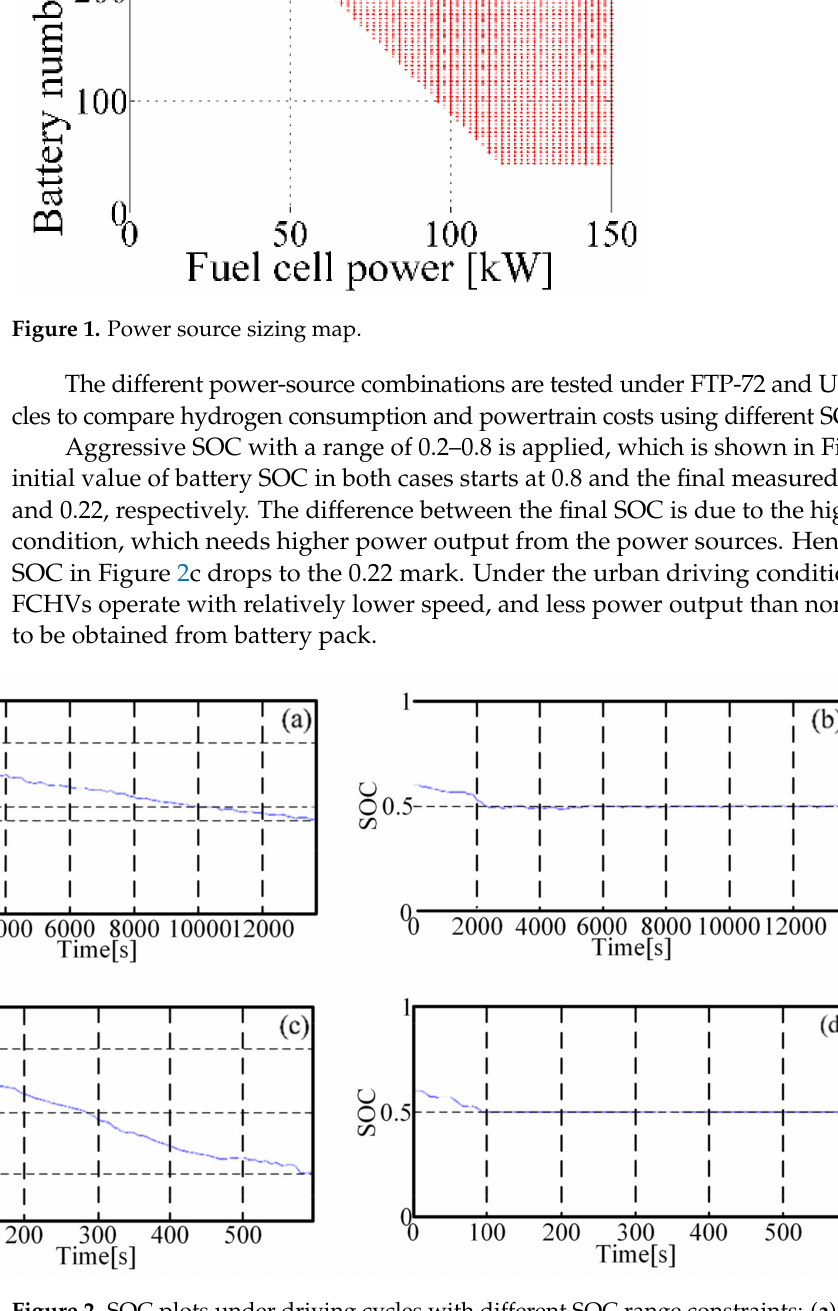
Figure 2. SOC plots under driving cycles with different SOC range constraints: ( a ) FTP-72 driving cycle, SOC 0.2–0.8; ( b ) FTP-72 driving cycle, SOC 0.5–0.6; ( c ) US06 driving cycle, SOC 0.2–0.8; ( d ) US06 driving cycle, SOC